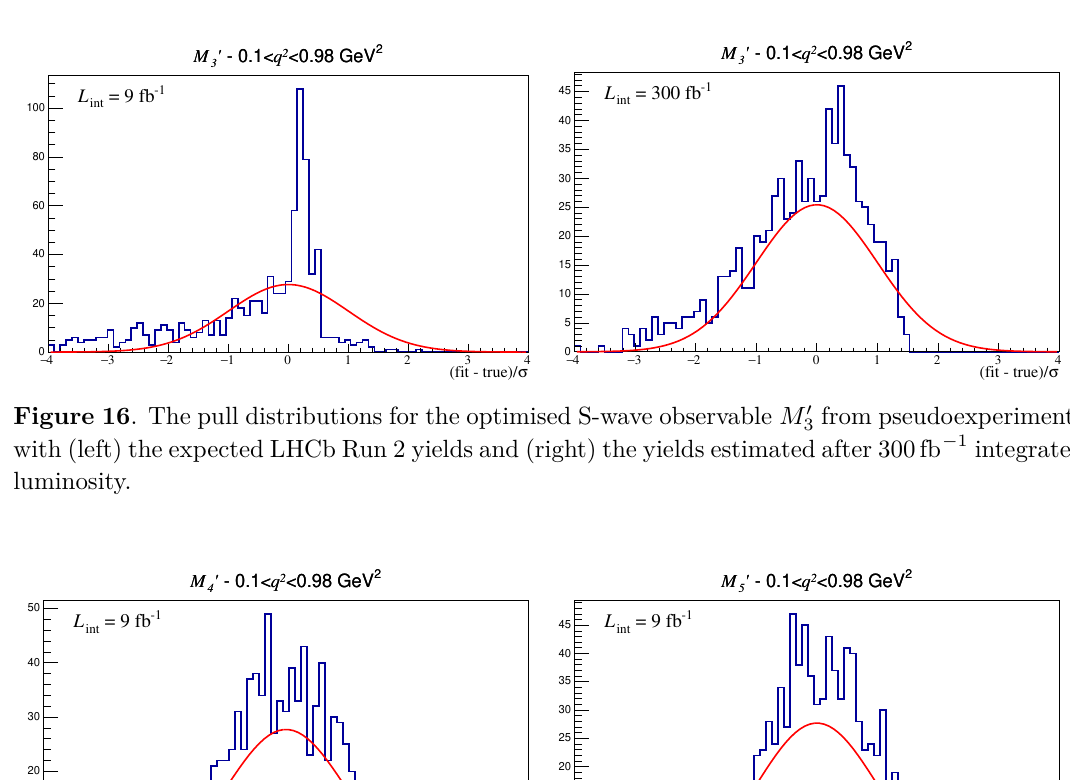
and (right) M 0 4 5